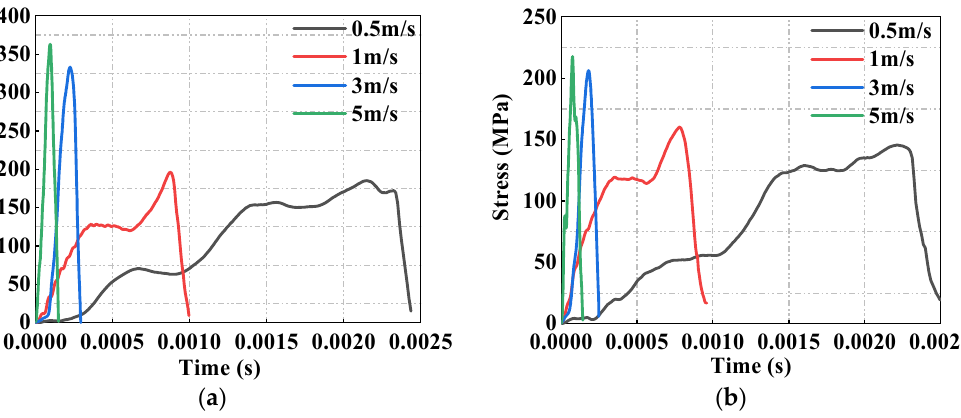
Figure 5. Stress response of partial MUHPC specimens under different impact velocities. ( a ) R0. ( b ) R100.